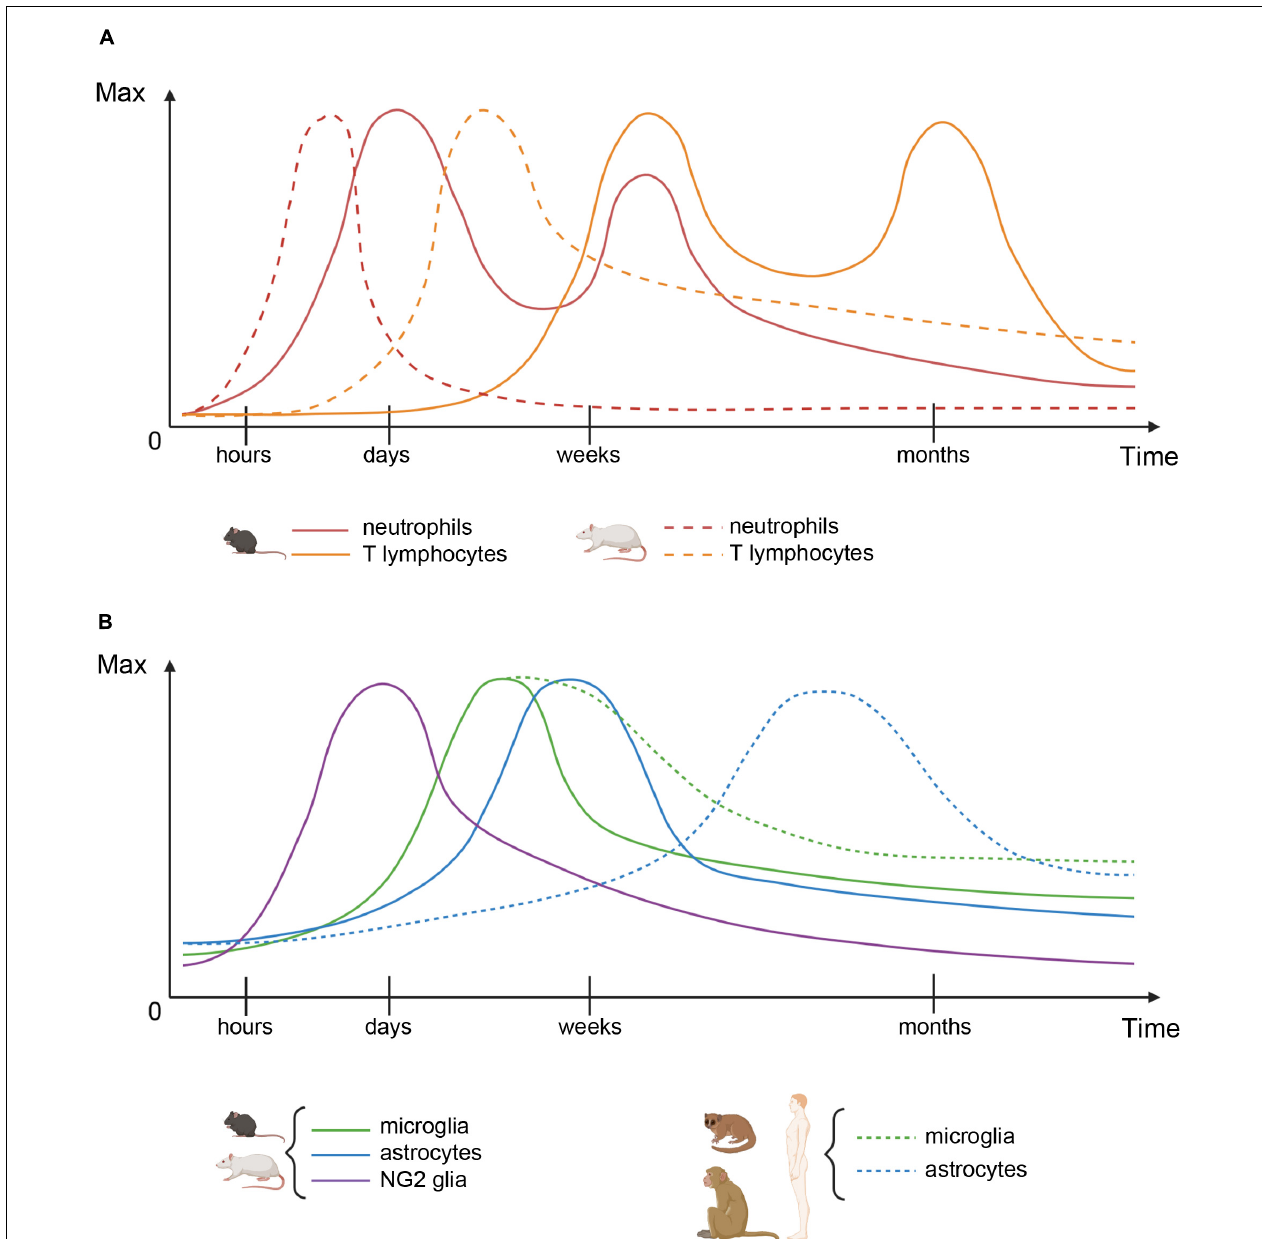
FIGURE 1 | Cellular dynamics after spinal cord injury. (A) Immune cell infiltration patterns in mice (plain lines) and rats (dashed lines). (B) Glial cell numbers in rodents (plain lines) and primates (dashed lines). For each cell type, both graphs represent the number of cells over time, relative to their maximum